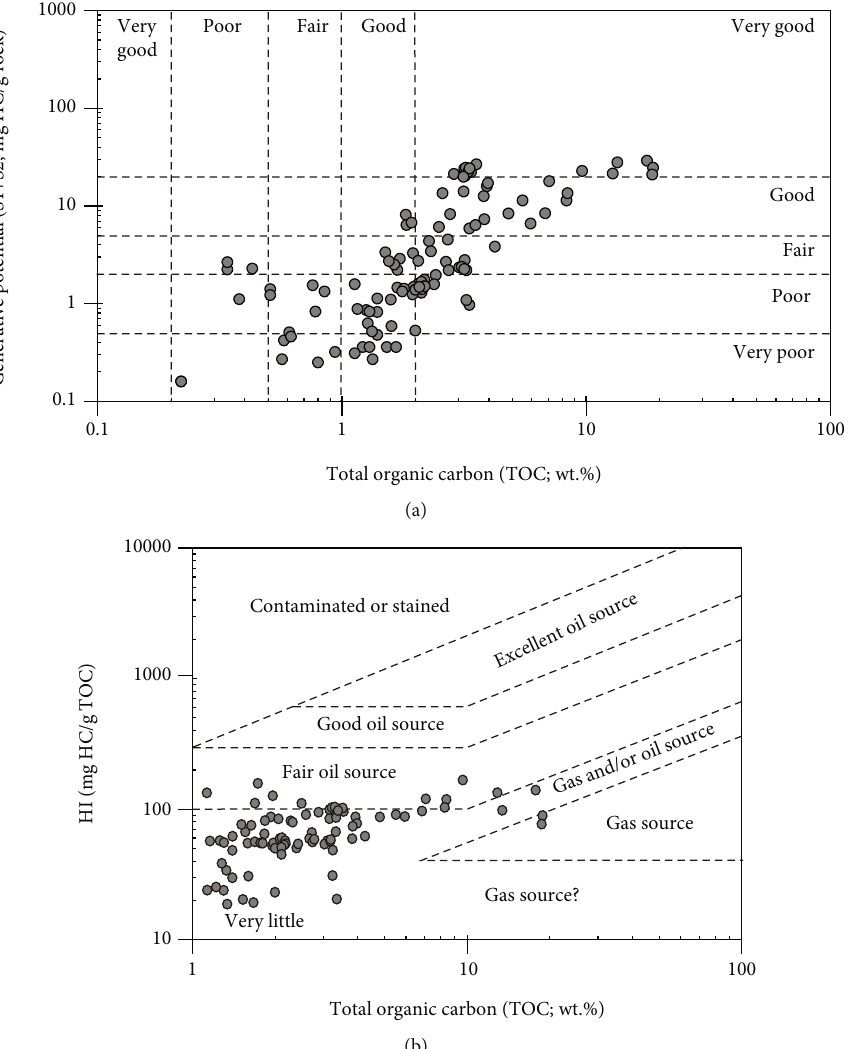
+ S 1 2 ) of the K 1 yc (according to [37]). (b) Plot of TOC vs. HI of